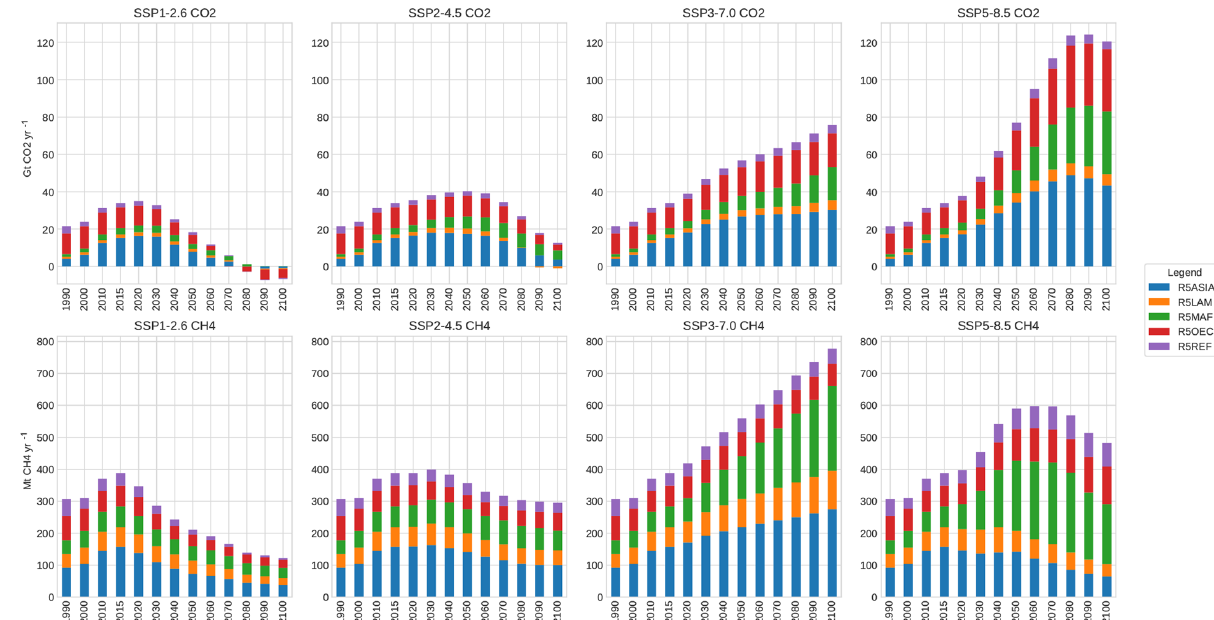
Figure 8. Regional emissions for five global regions for CO 2 and CH 4 in each Tier-1 scenario.